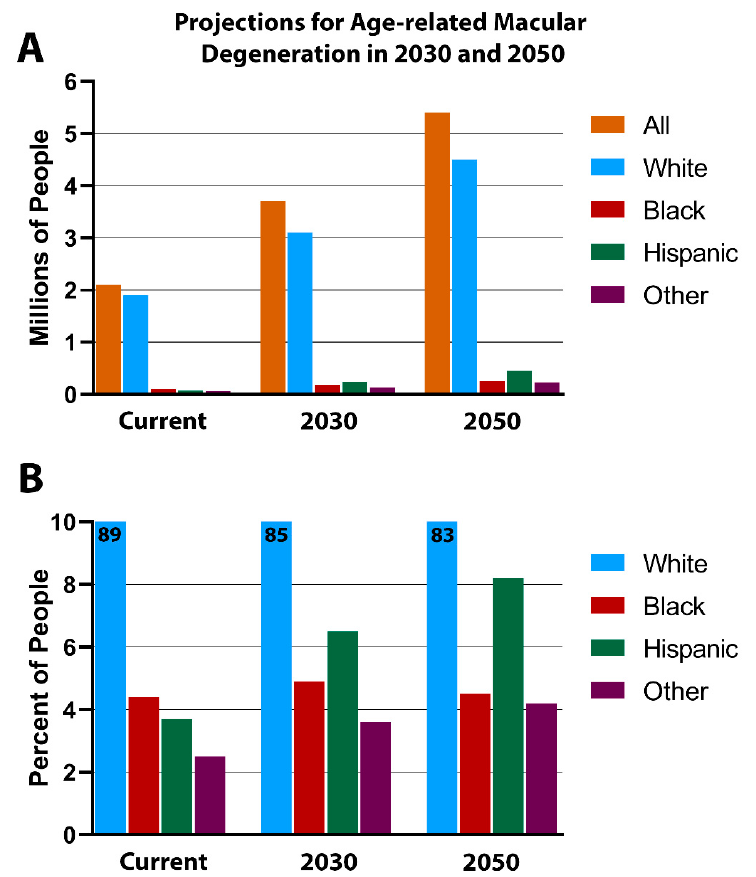
Figure 3. Projections for age-related macular degeneration. The white population will continue to account for most age-related macular degeneration (AMD)-related cases, as the disease incidence level is expected to more than double by 2050, from 2 million to 5.4 million people ( A ). The percentage of people affected with AMD by race is illustrated in ( B ). Races with the highest levels of pigmentation have the lowest incidence of AMD, which is possibly due to the stimulation of GPR143 by L-DOPA. Image adapted from the National Eye Institute’s AMD Data Tables, last updated July 17, 2019.